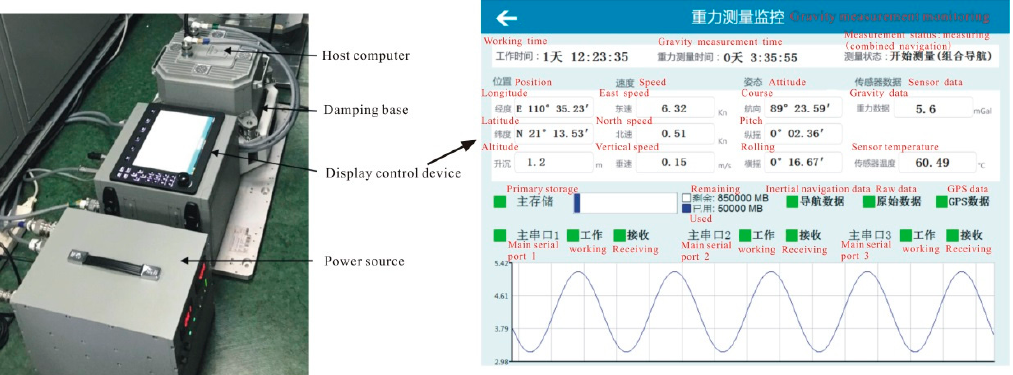
Figure 3. The Sea-Air Gravimeter-2Marine (SAG-2M) system and its operating interface.